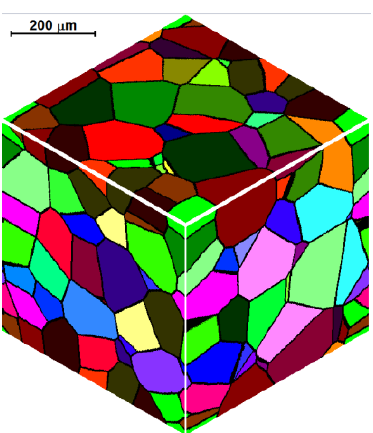
Figure 2. Example of microstructure with periodic boundary conditions.